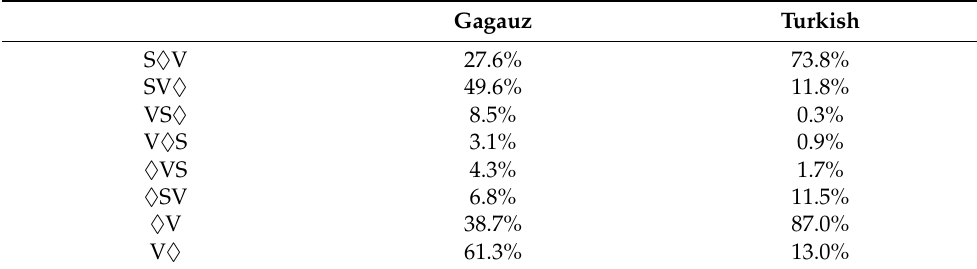
Table 3. Constituent orders in Gagauz and